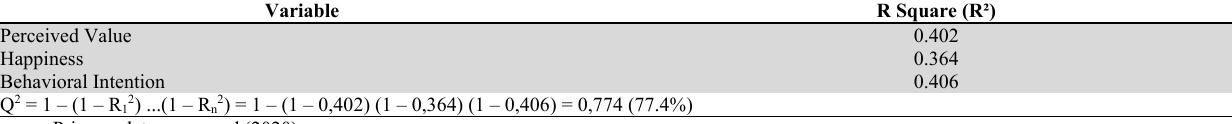
Goodnesss of Fit Model Test Results